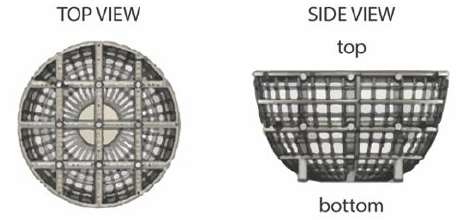
Figure 1. Schematic of ultra-large scaffold showing top view and side view representations [19].